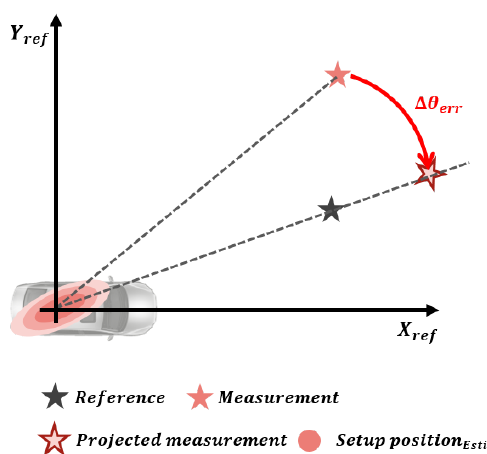
Figure 5. Orientation error estimated by the projection approach.